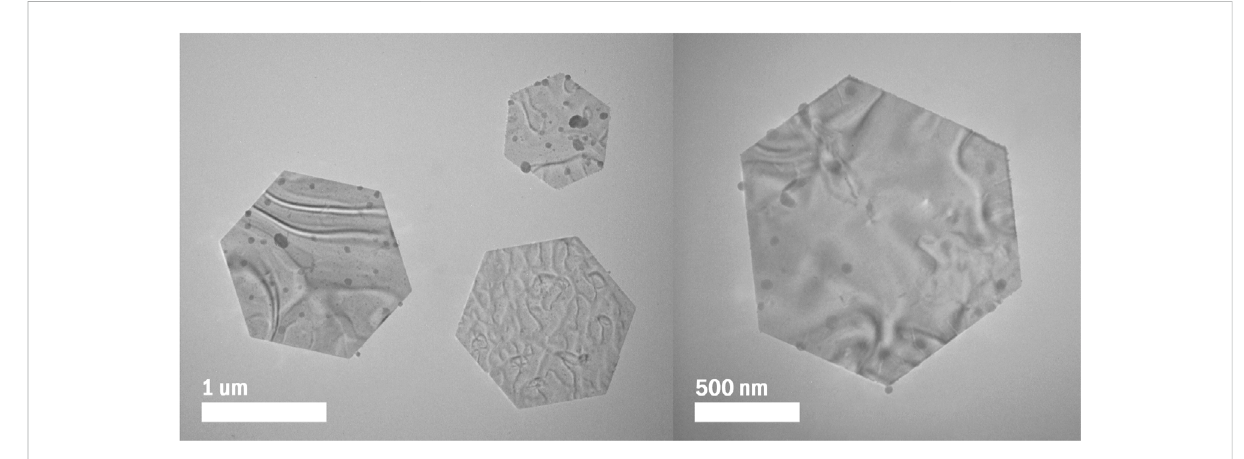
FIGURE 3 TEM images of fl at, hexagonal Sb 2 Te 3 nanoplates.